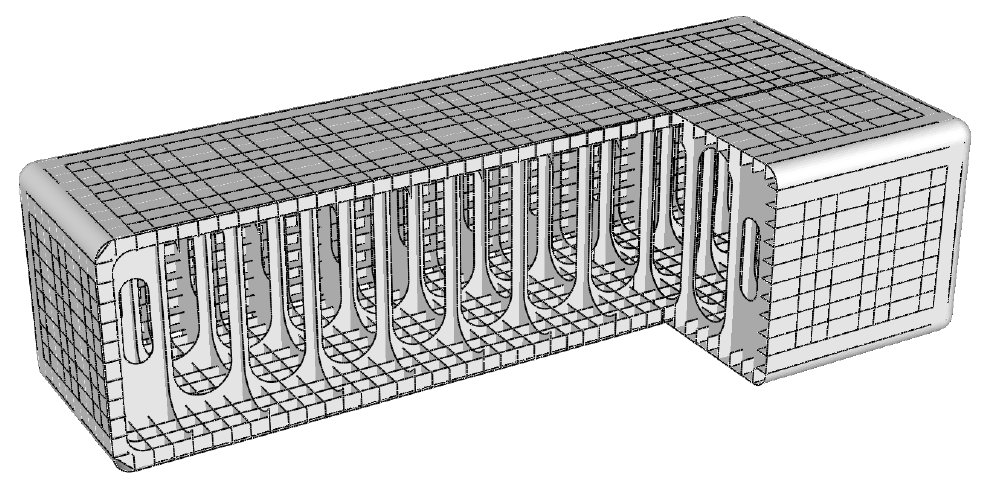
Figure 3. Configuration of plate-stiffened prismatic pressure vessel.